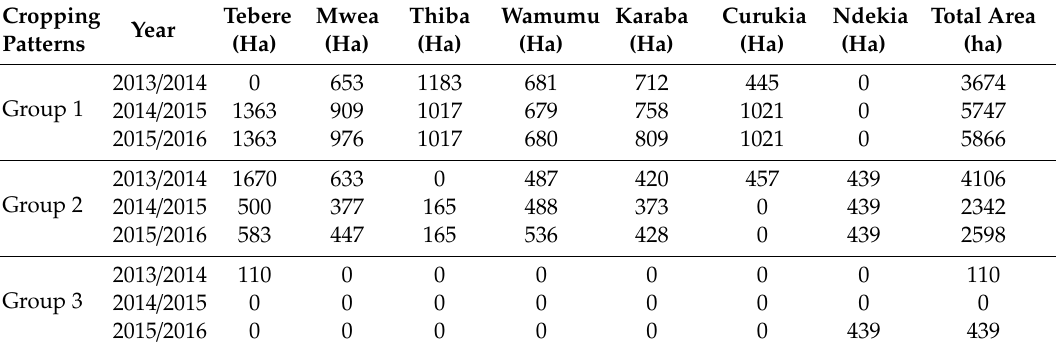
Table 3. Comparison of irrigation areas in groups, blocks and years of existing cropping patterns. Cropping